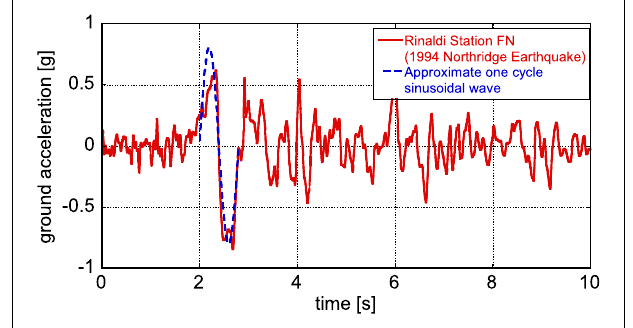
FIGURE 14 | Modeling of part of pulse-type recorded ground motion into the corresponding one-cycle sinusoidal input (Rinaldi station fault-normal component during the Northridge earthquake in 1994)